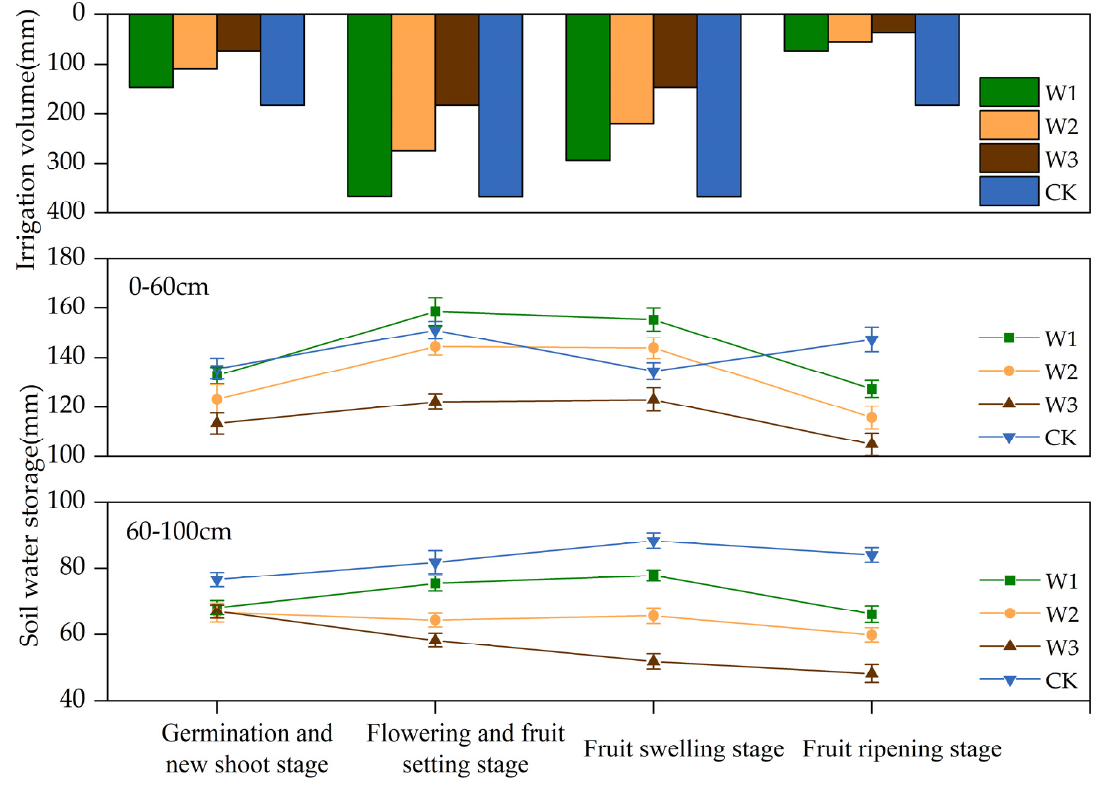
Figure 5. Soil water storage in the 0–100 cm soil layer at different growth stages (2018). W1, W2, and W3 indicate irrigation amounts of 880, 660, and 440 mm under drip irrigation, CK indicates an irrigation amount of 1100 mm under flood irrigation. Vertical bar represents standard error.